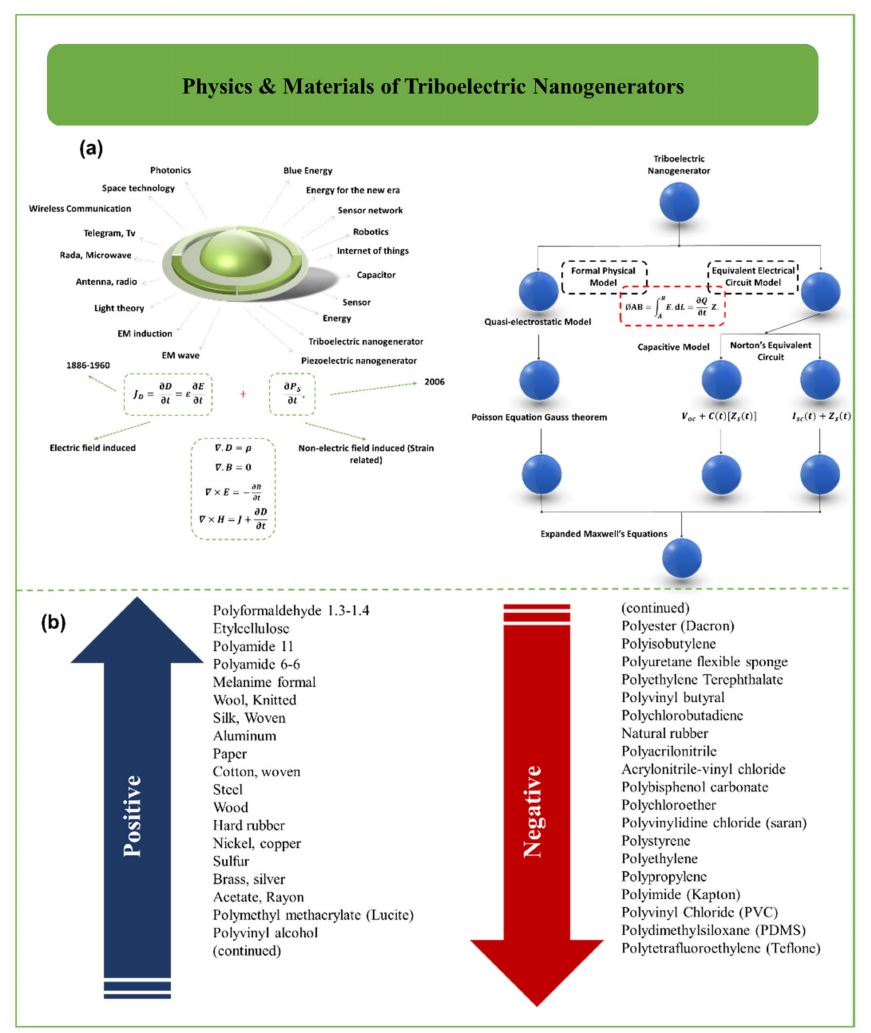
Figure 3. ( a ) Description of the fundamental theories relating to the physics of TENGs. ( b ) Triboelec- tric series for some common materials